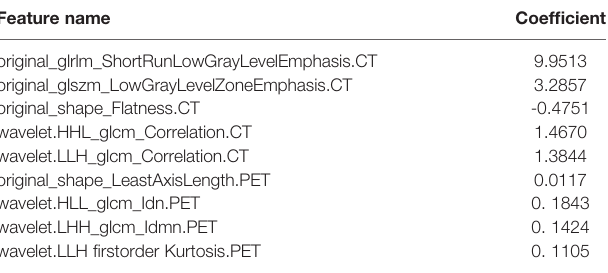
TABLE 4 | Radiomic characteristics and signi fi cance of PET/CT radiomic scores (Rad-scores) used to calculate PFS. Feature